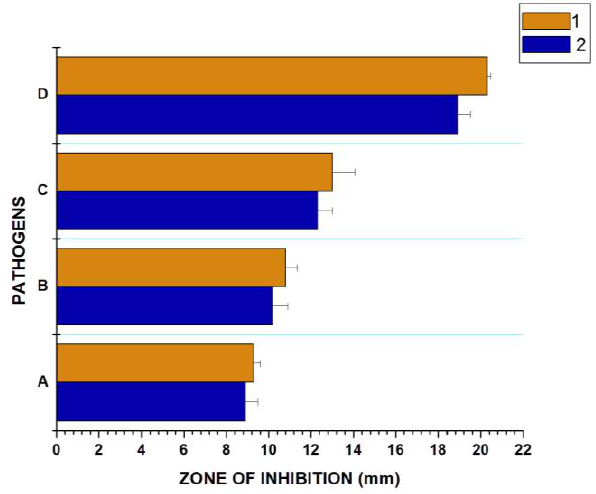
Figure 8. Antibacterial activity of PTAgNPs. 1 — E. coli , 2 — S. aureus . ( A ) 25 µg/mL; ( B ) 50 µg/mL; ( C ) 75 µg/mL; ( D ) control gentamicin 20 µg/mL.